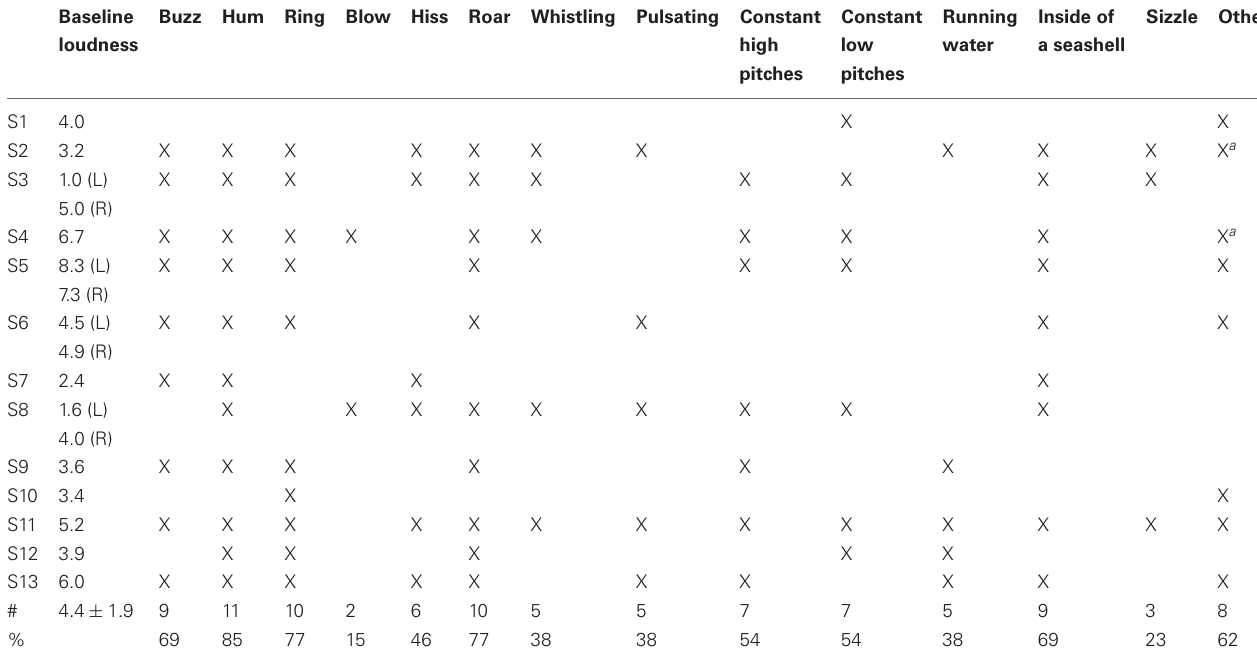
Table 3 | Tinnitus characteristics.